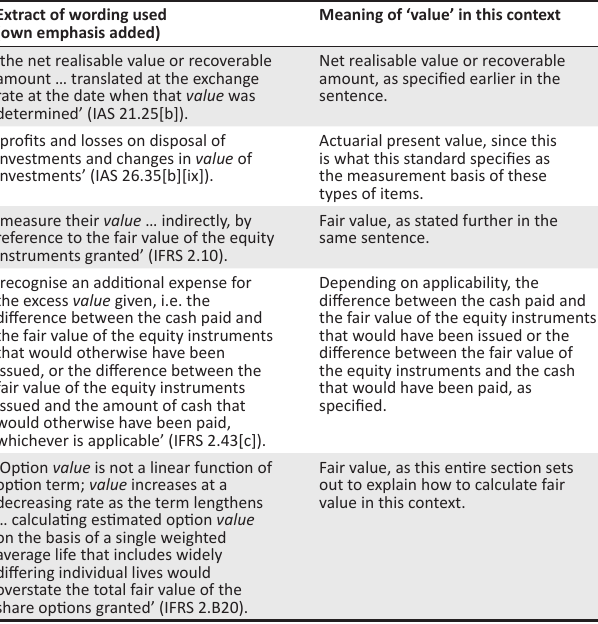
TABLE 2: Some examples where ‘value’ is used as a standalone term in International Financial Reporting Standards. Extract of wording used Meaning of ‘value’ in this context (own emphasis added)